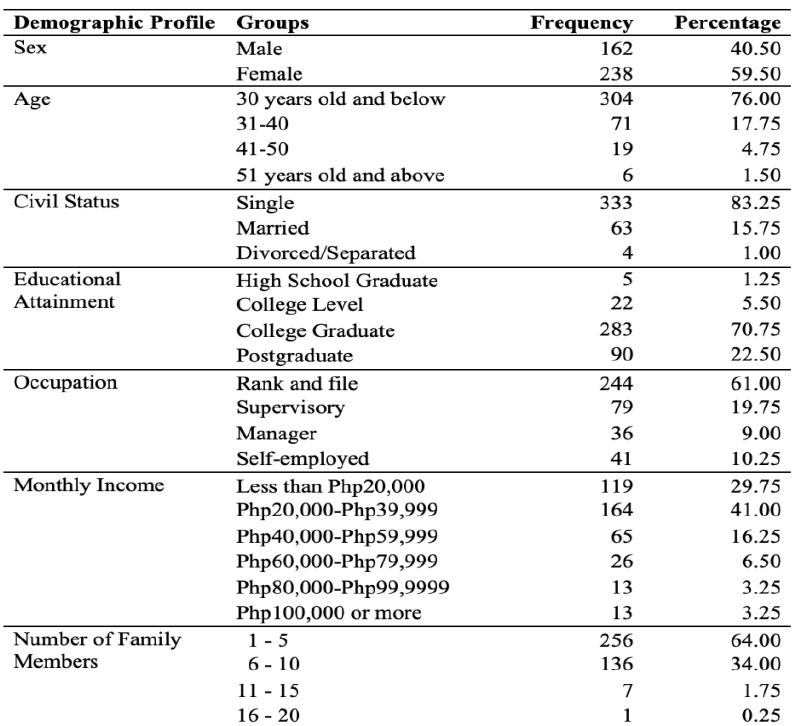
Table 1: Demographic Profile of the